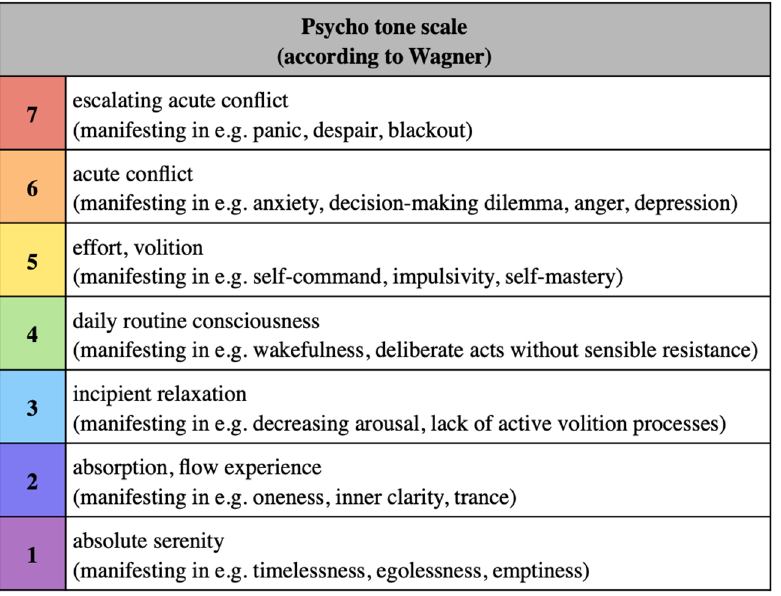
Figure 1. Psycho tone scale (stage names and characteristics of manifestation according to Wagner [2007] 2021), translated from German. The seven colors representing the seven stages in the “Psycho tone scale” (see Figure 1) are not included in the original description of the system (cf. Wagner [2007] 2021). They were added by the author to support intuitive understanding of each stage (being aware that such an approach is not fully backed up by scientific evidence). 15.